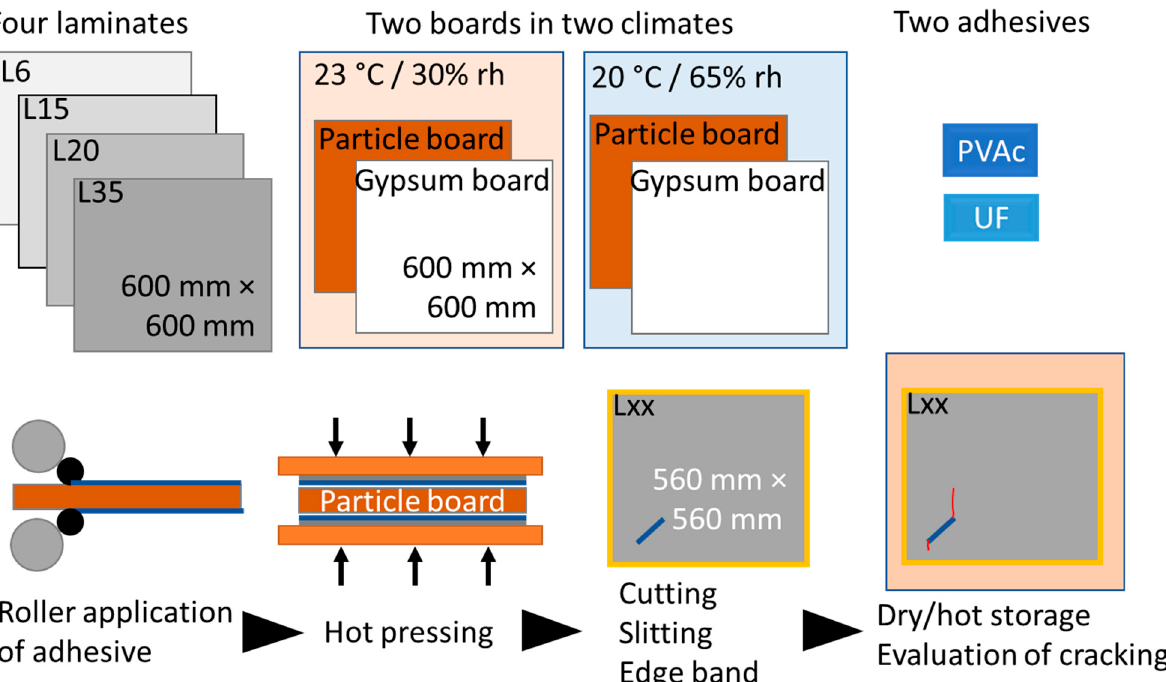
Figure 2. Schematic illustration of the second trial.